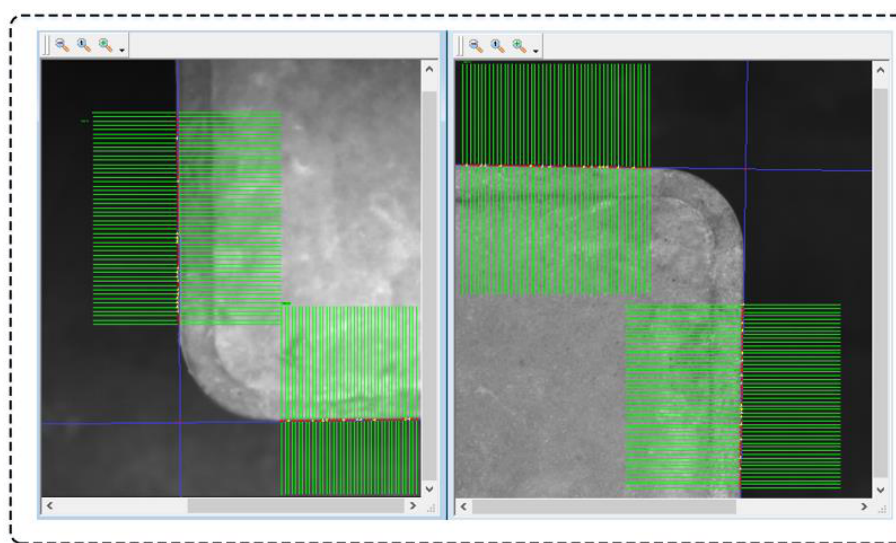
( b ) Figure 15. ( a ) Device distribution model. ( b ) Diagram of device connection. A visual representation of the target localization results in the image processing soft- ware is shown in Figure 16. Two regions of interest are set separately for a single image in the figure, and these two regions of interest are sufficient to cover all possible locations